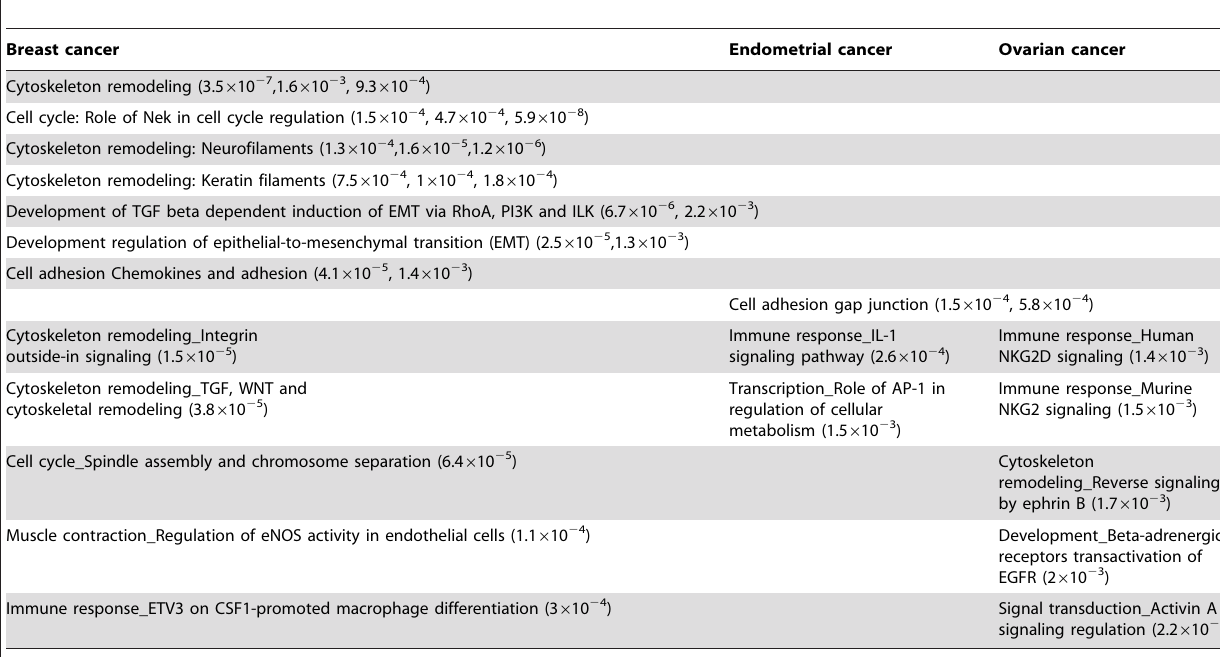
Table 3. Pathway enrichment analysis of the three gene signatures altered between eribulin and paclitaxel treatments.